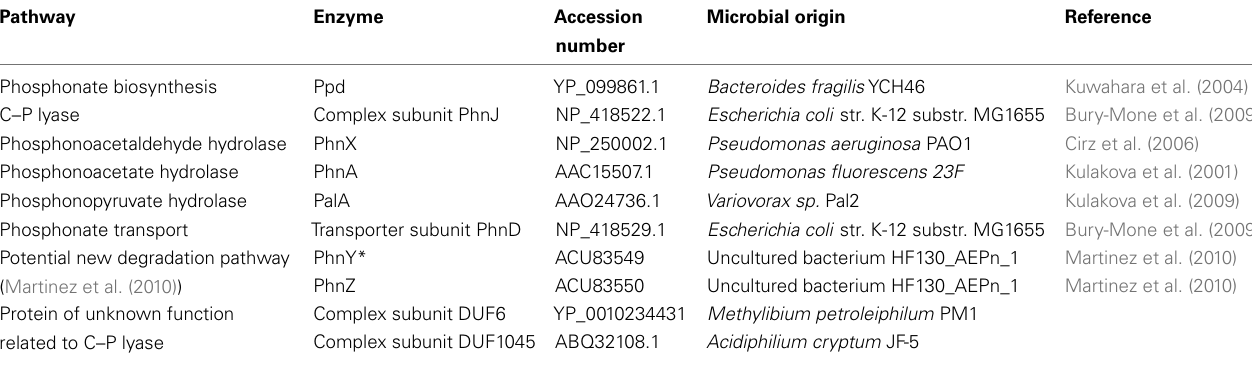
Table 1 | Polypeptides used as query sequences for bioinformatic